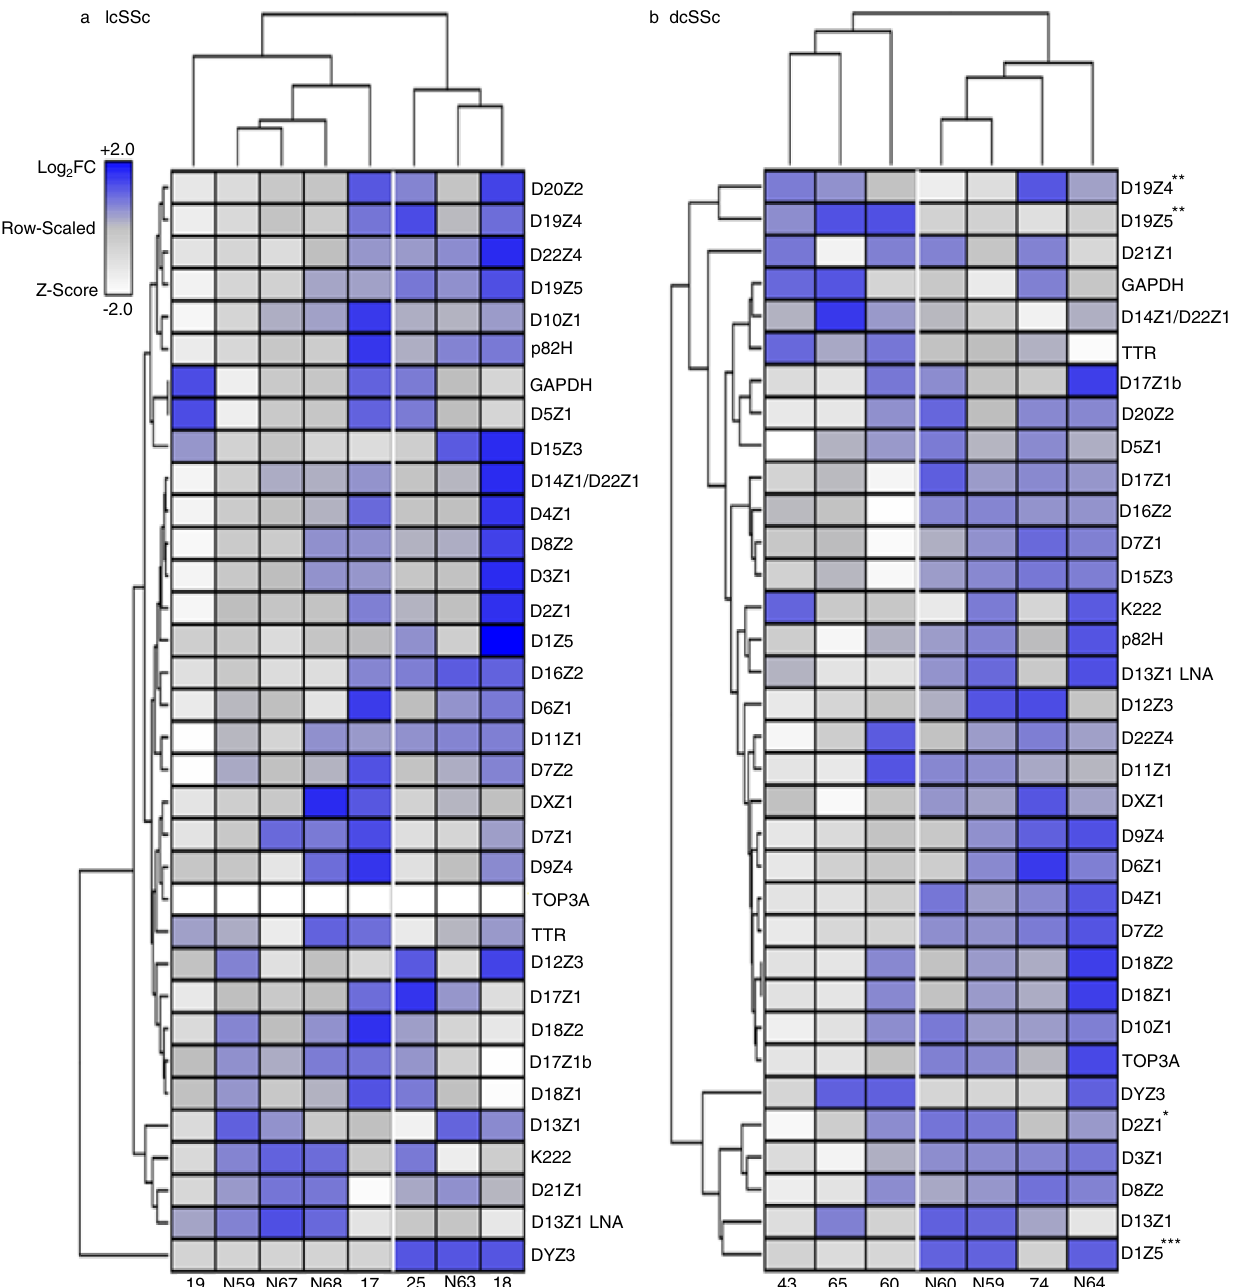
Fig.1|Centromeresizevariationinprimary fi broblastsfrompatientswithSSc. a A heatmap depicting alpha-satellite content (rows) obtained by qPCR in 50ng of DNA from fi broblasts obtained from healthy individuals (N59, N63, N67, and N68) andpatientswithlcSSc(17,18,19,25).Unsupervisedhierarchicalclusteringanalysis was conducted to ascertain if distinct genetic signatures distinguish healthy fi broblasts from lesion fi broblasts. Normal samples are noted to cluster with dis- eased samples, suggesting that centromeric alterations in fi broblasts obtained from patients with lcSSc do not diverge from variations that occur at baseline in fi broblasts obtained from health individuals. b A heatmap depicting alpha-satellite content in fi broblasts from healthy individuals (N59, N60, and N64) and patients withdcSSc(43,60,65,and74).WiththeexceptionofthedcSScsample74,diseased samples are distinct genetically at the centromeric locus as compared to healthy